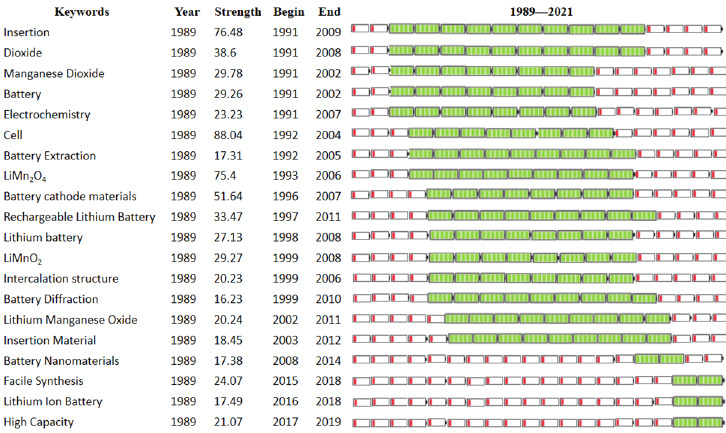
Figure 6. Prominence keyword mapping. Green means: the direction is in hot research, red means: it has relatively reached generalization or is not taken seriously.